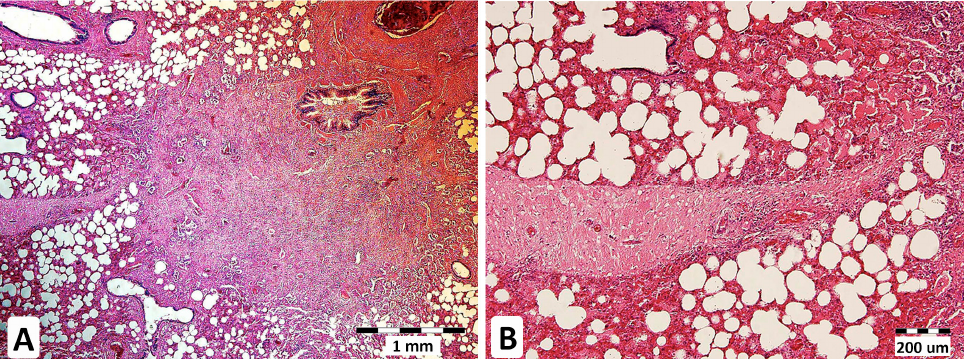
Figure 4. Chronic interstitial pneumonia in equine IPA. The formation of fibrous nodules in the lung parenchyma, HE stains, magnification 40× ( A ). Multifocal thickening of interalveolar septa with prominent fibrosis (indicated by a strand of fibrous tissue) in a lung parenchyma sample stained with hematoxylin-eosin (HE) ( B ) at 100× magnification.